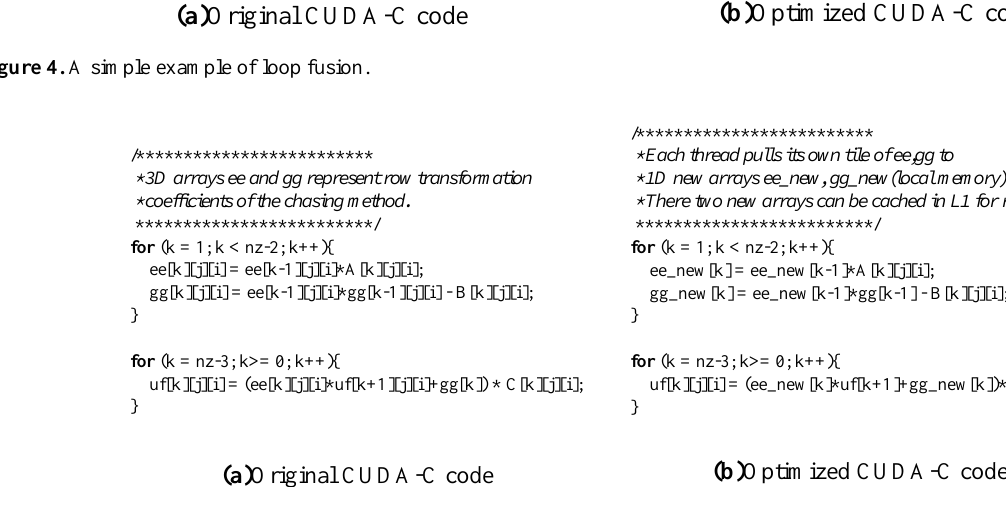
Figure 4. A simple example of loop fusion.